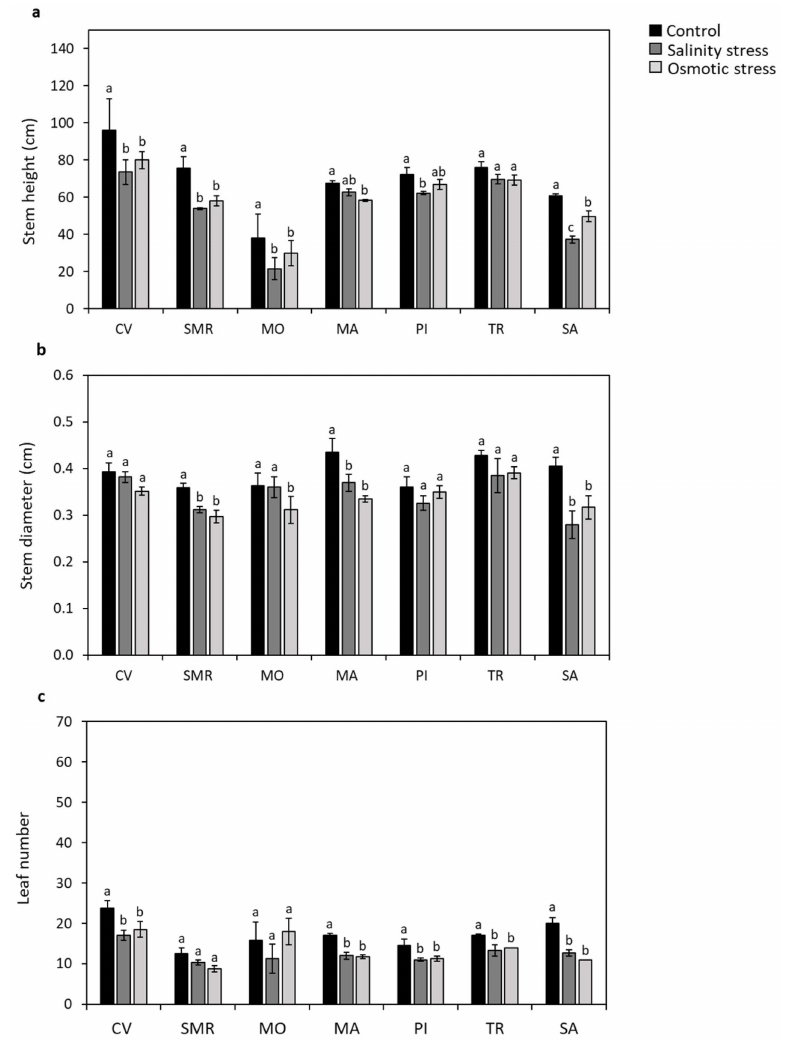
Figure 4. Plant morphological features. Stem height ( a ), diameter ( b ), and leaf number ( c ) of seven common bean populations grown under controlled, salt-, and osmotic-stress conditions. Data represent the mean ( n = 4) ± standard error. A Student’s t -test was conducted to weigh the effects of different treatments ( p ≤ 0.05). Mean values marked with the same letter are not statistically different. CV: Ciliegino; SMR: San Michele Rosso; MO: Monachella; MA: Mascherino; PI: Pinto; TR: Tuvagliedda Rossa; SA: Suocera e